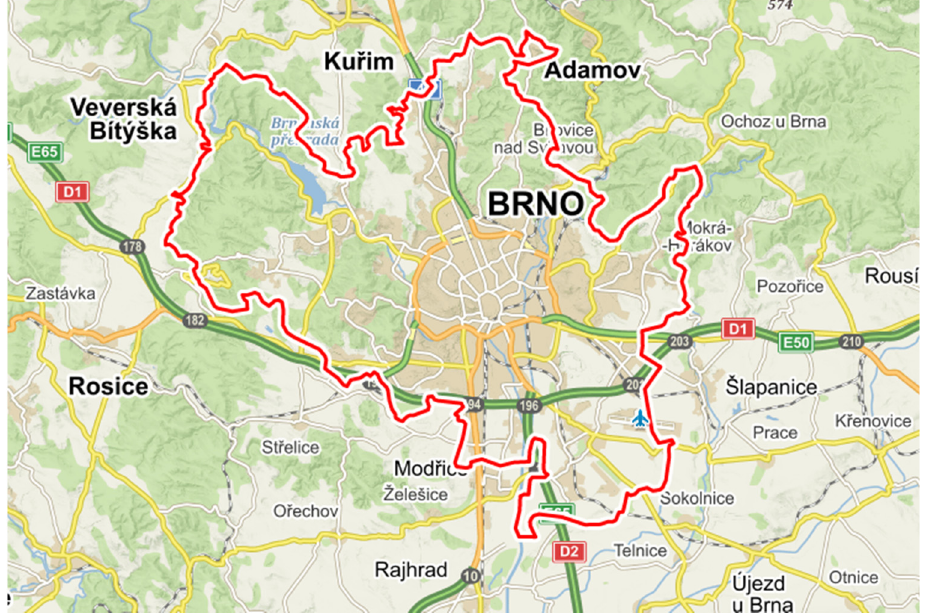
Figure 1. A map of Brno and the location of Brno city [63].